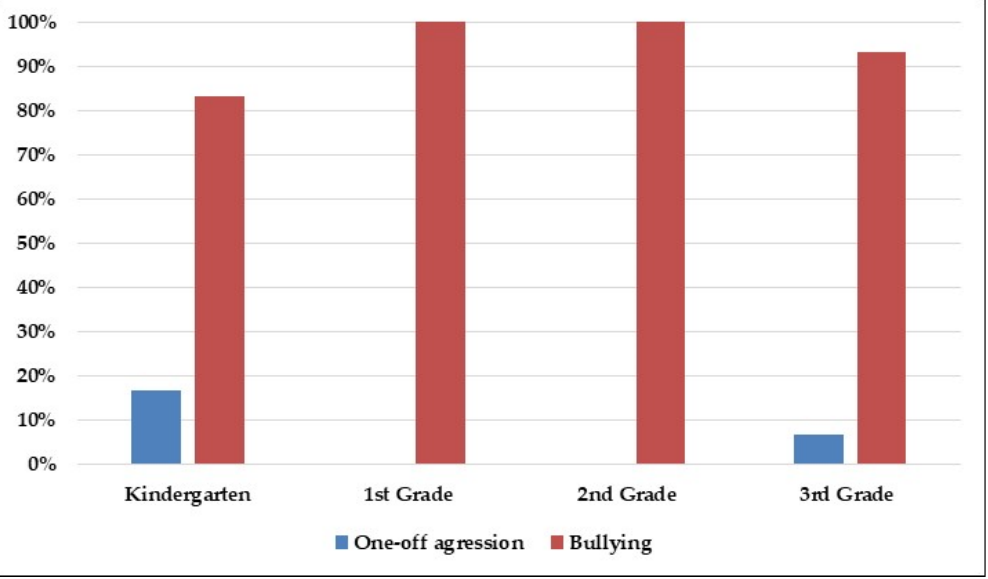
Figure 2. Type of aggression per grade.